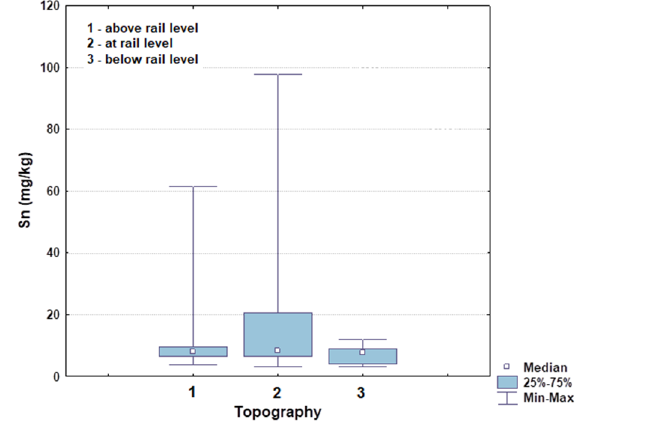
( b ) Figure 8. Dependence of concentration of Sn ( a ) and Sb ( b ) in soil and railway age (boxplots were obtained by Kruskal–Wallis ANOVA followed by a pairwise comparison using Dunn’s method, with the significance level set at p < 0.05). Similar results were also obtained by other authors. Chen et al. [19] investigated the effect of railway operation time on contamination levels. Their results indicate an increase in contaminant concentrations (Cd and Pb) with the duration of railway operation. Wi ł ko- mirski et al. [41] indicated a significant increase in PAH concentrations in comparative studies conducted in 1995 and 2008 (after 13 years) at the same sites, although the same was not observed for HM concentrations. In fact, elevated HM concentrations were only observed at some of the sites studied.